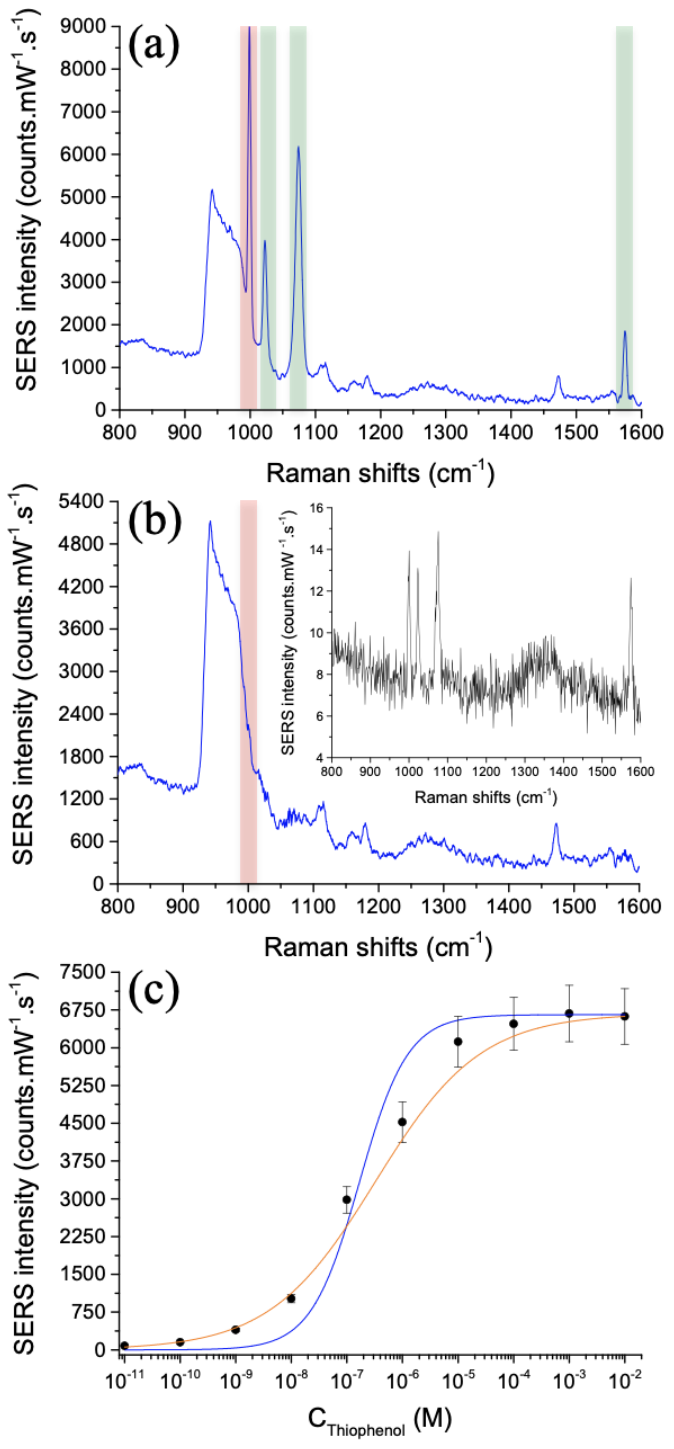
Figure 4. ( a ) SERS spectrum of thiophenol molecules (concentration of 1 mM) on hybrid asymmetric dimers. The Raman peak at 999 cm − 1 is encapsulated in a red rectangle that we have chosen to use for assessing the sensitivity of hybrid asymmetric dimers, and the Raman peaks at 1023, 1075 and 1575 cm − 1 are encapsulated in a green rectangle. ( b ) SERS spectrum of thiophenol molecules (concentration of 10 pM = limit of detection) on hybrid asymmetric dimers. The inset displays the SERS spectrum of thiophenol molecules (1 mM) recorded on the gold film ( c ) SERS intensity versus thiophenol concentration ( C S ). The black points correspond to the experimental results, and the blue and orange curves correspond to the Langmuir and Hill models,